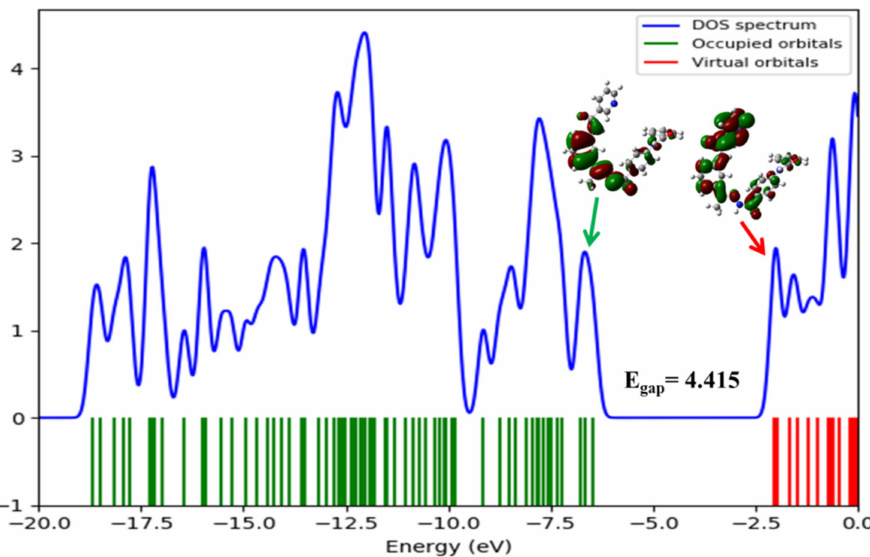
Figure 12. Molecular frontier orbital spectrum, their energies, and total density of states (TDOS) obtained at B3LYP/6-311++G(d,p) level for title molecule.